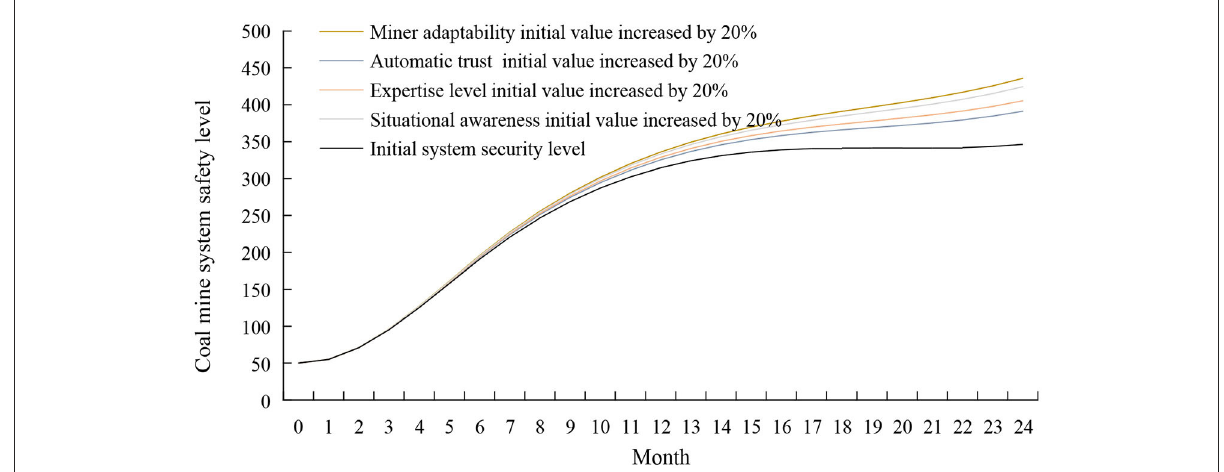
FIGURE8 Simulation results of coal mine system safety after the intervention of miners’ individual